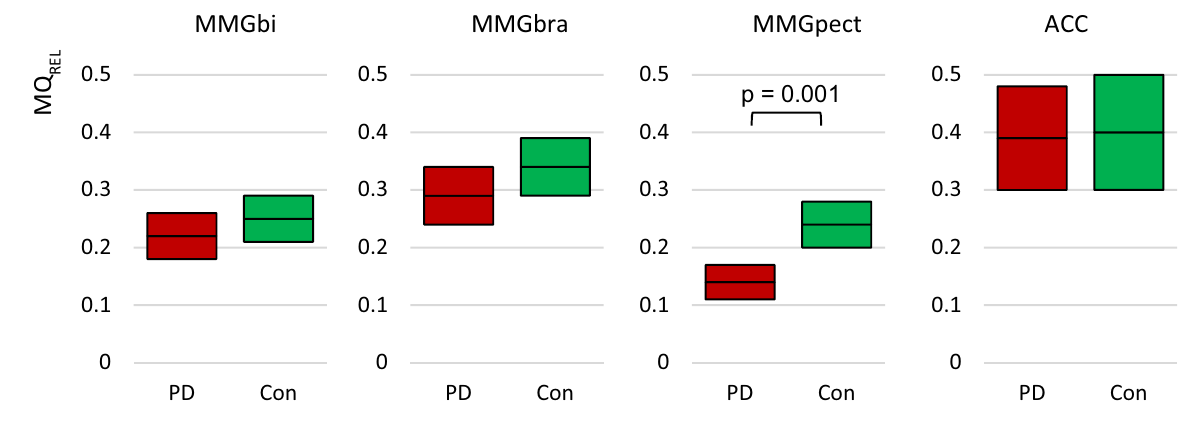
Figure 3. Specific ratio MQ REL . Displayed are the 95% confidence intervals of the arithmetic mean of the specific ratio Q rel (MQ REL ) of the MMGs and the ACC signals. As can be seen in the MMG-signals, the PD have a lower ratio compared to controls. However, only concerning the MMGpect significant differences of p = 0.001 occur. The CIs of the ACC signal are overlapping